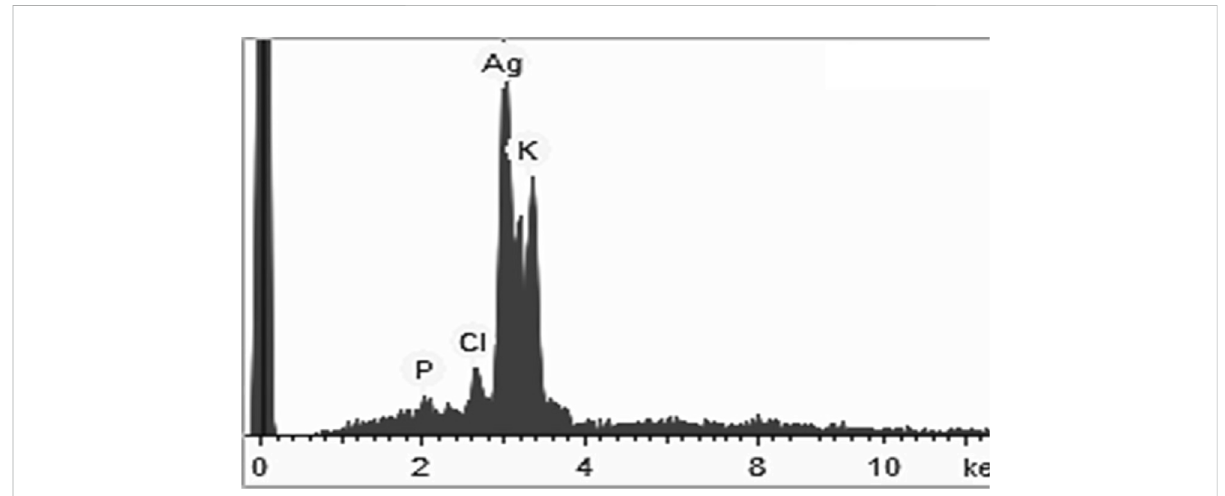
FIGURE 5 EDX analysis of AgNP synthesized by Rhodiola rosea .